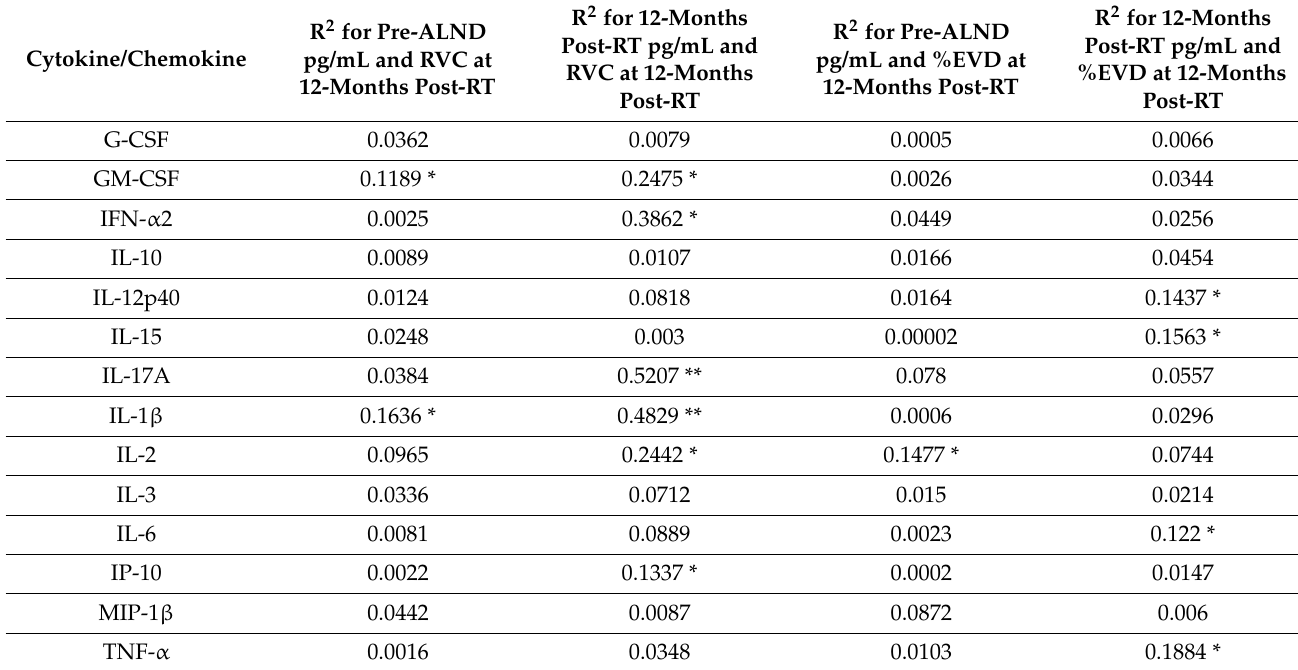
Table 2. Pearson correlation values comparing pre-ALND and 12-months post-RT plasma cy- tokines/chemokine levels to %RVC and